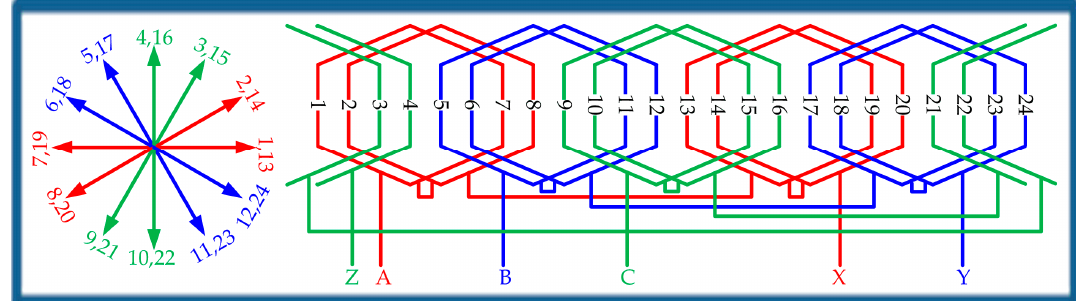
Figure 3. Slot electrical potential star vectogram and winding connection.